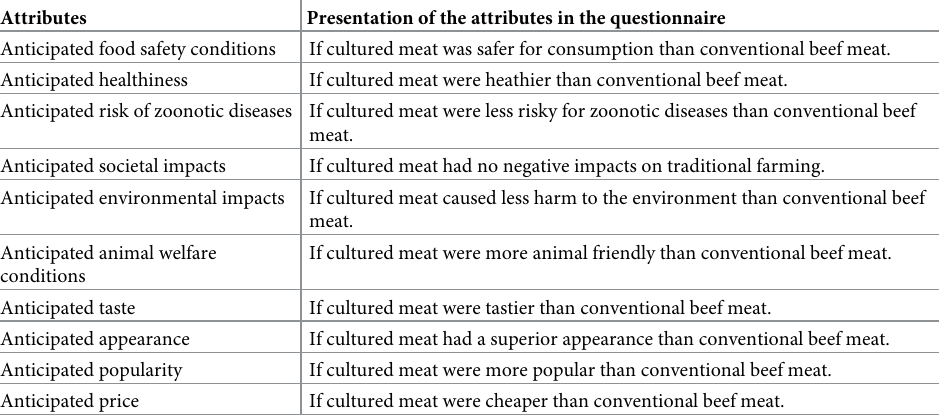
Table 1. List of attributes used for the best-worst